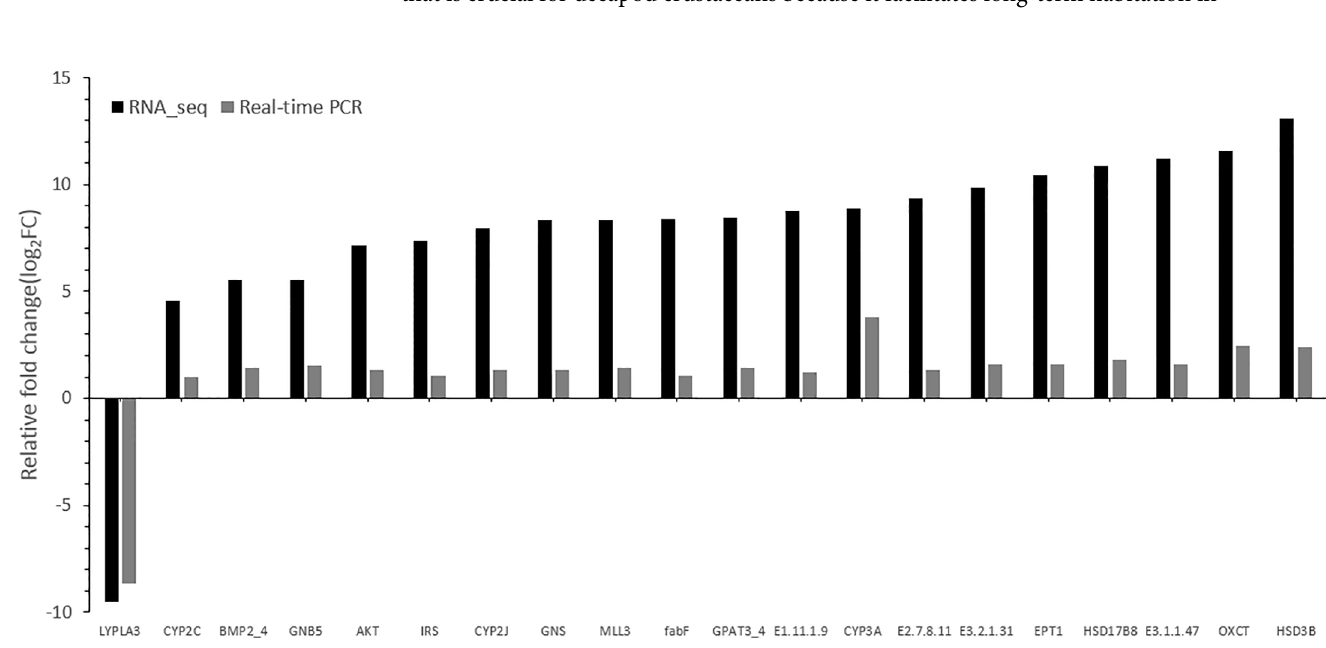
Fig 6. Validation results of RNA-seq profiles by